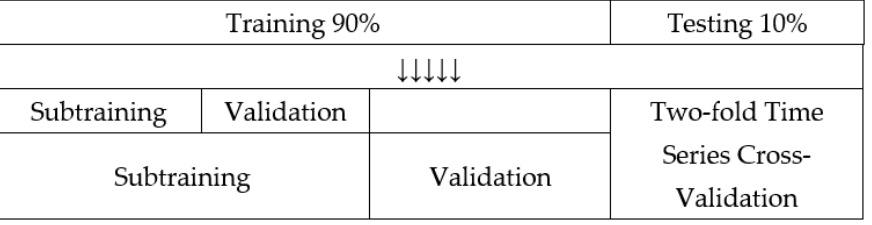
Table 5. Class weights.